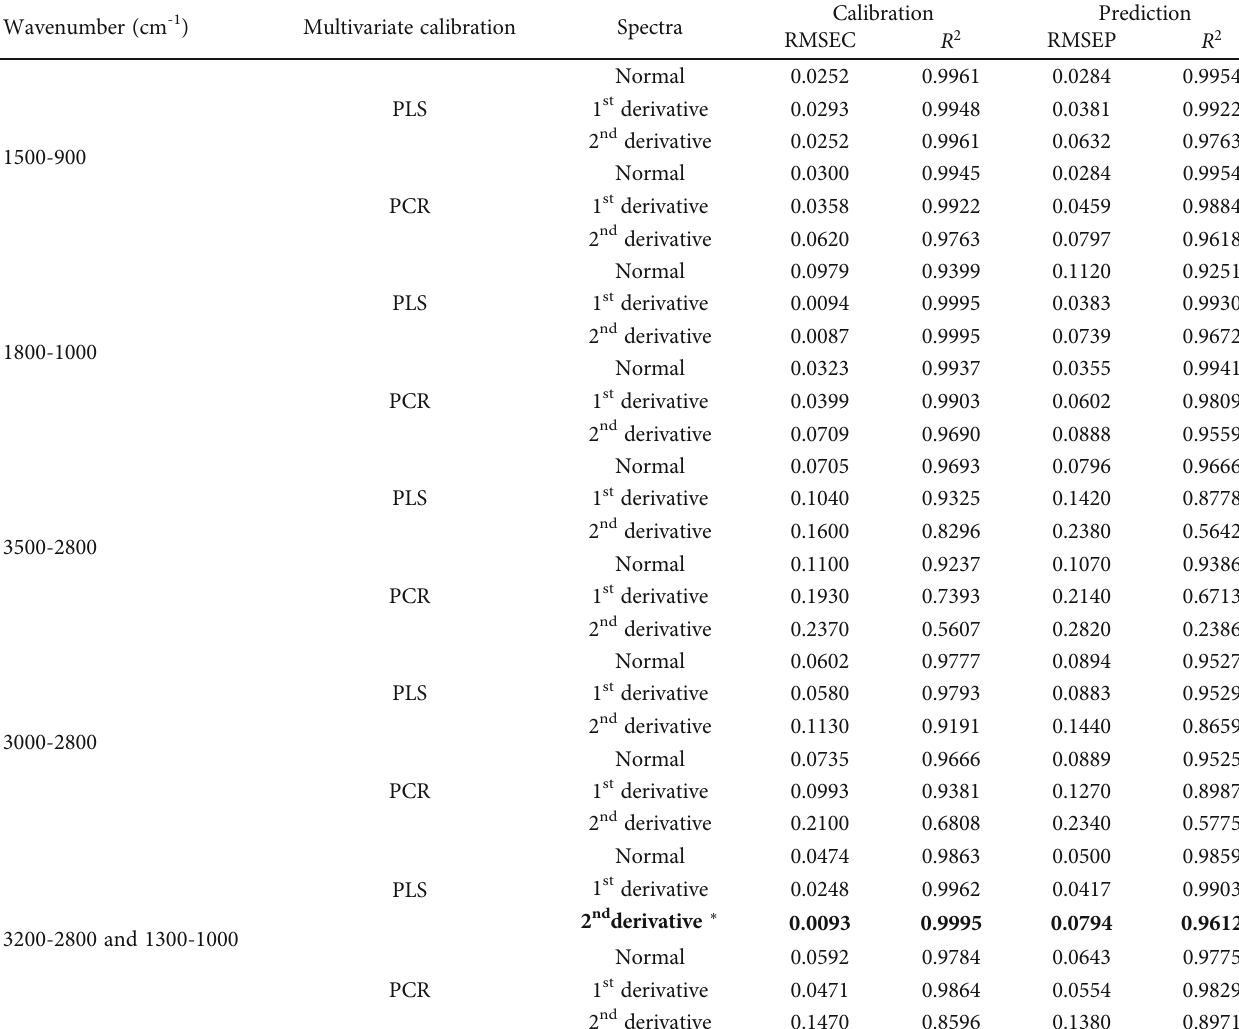
Table 3: The optimization wavenumber region of multivariate calibration for authentication of horse ’ s milk in binary mixture with goat ’ s